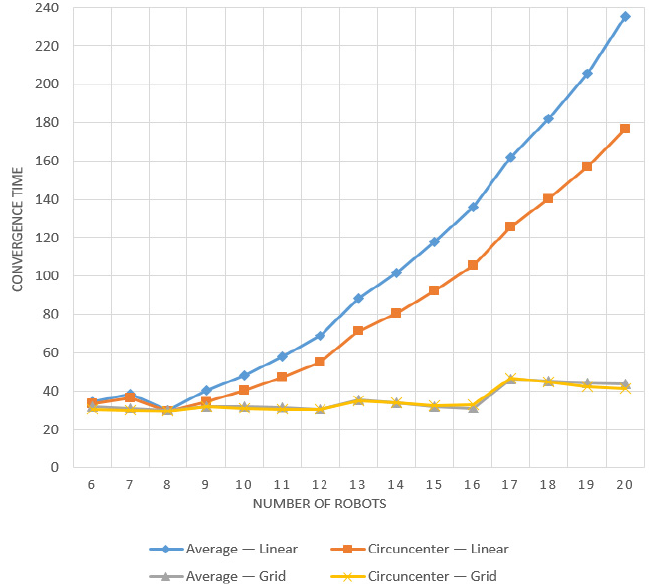
Figure 9. Results of varying the number of robots with two different control algorithms (Average × Circumcenter) and two fixed communication topologies (Linear × Grid).